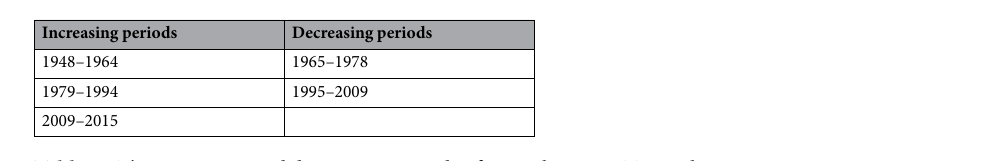
Table 1. The increasing and decreasing periods of annual average TWSA between 1948 to